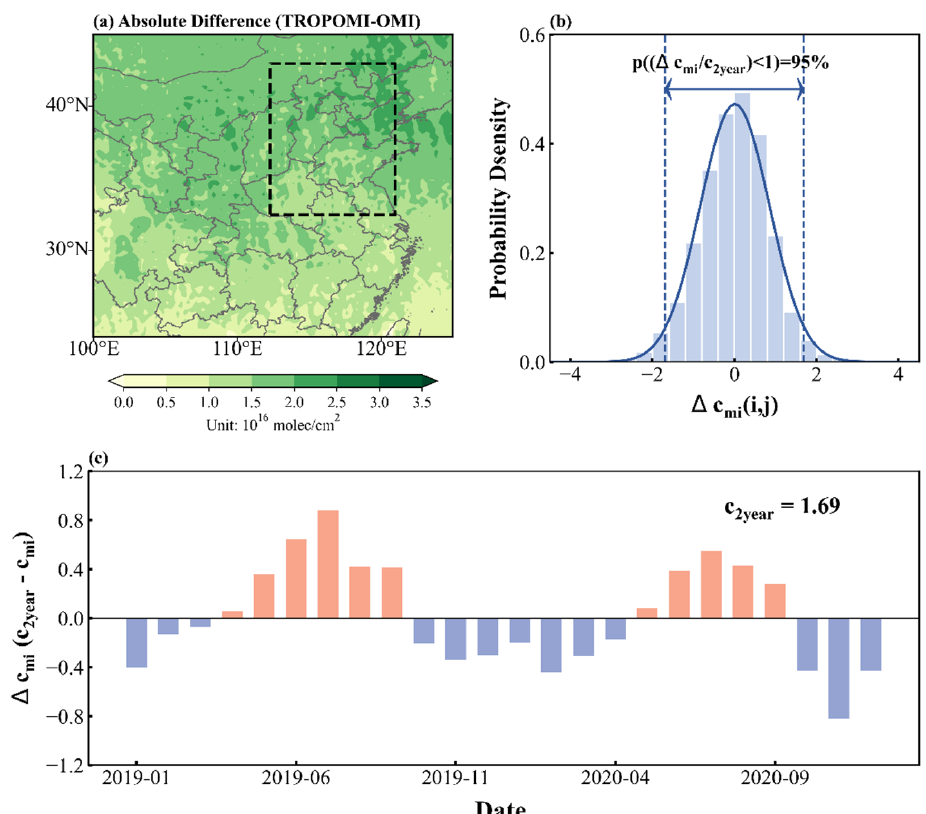
Figure 8. ( a ) The map of the absolute difference between TROPOMI and OMI SO 2 VCDs averaged during 2019 and 2020 (i.e., c s ( i , j ) in Equation (3)). Black box represents the NCP area. ( b ) Probability density distribution diagram of the ∆ c mi ( i , j ) for all months and all pixels over the NCP region in 2019–2020. ( c ) Bar-chart plot representing the temporal evolution of the regional mean ∆ c mi (units: 10 16 molec cm − 2 ).